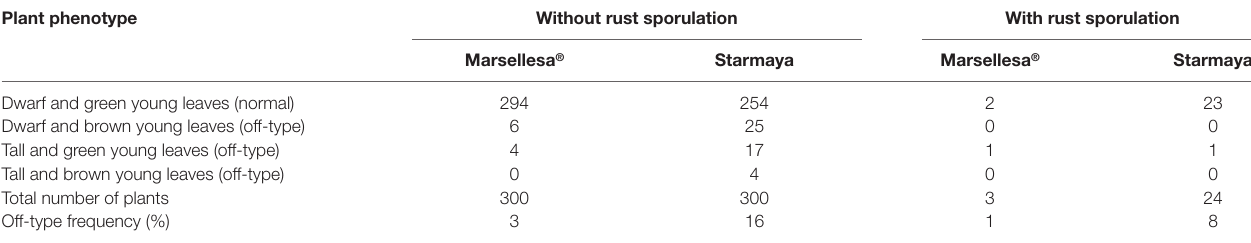
TABLE 6 | Evaluation of off-type frequencies based on plant phenotype and leaf rust sporulation for Marsellesa ® and